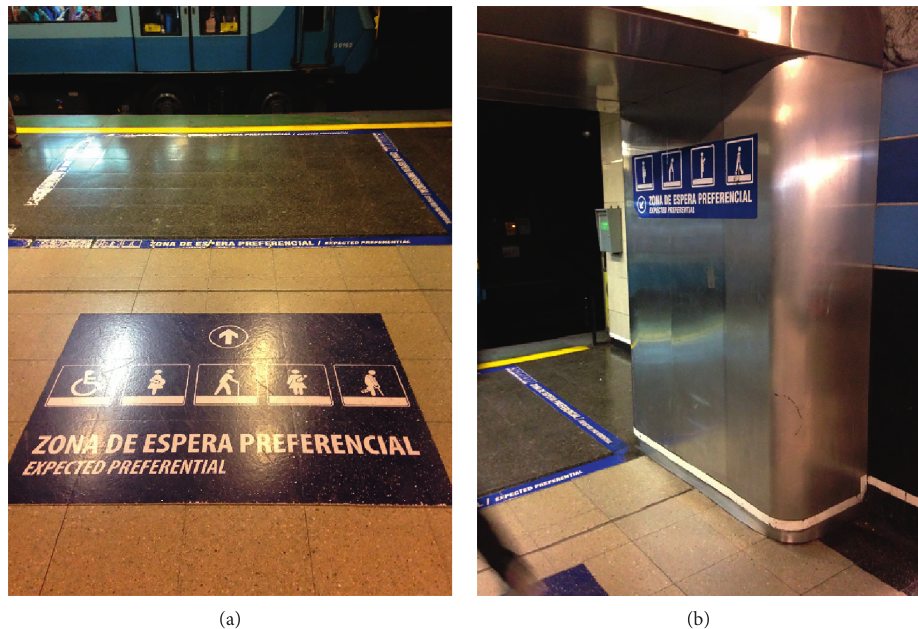
Figure 1: Preferential waiting area at Tobalaba station, line 1, Metro in Santiago.